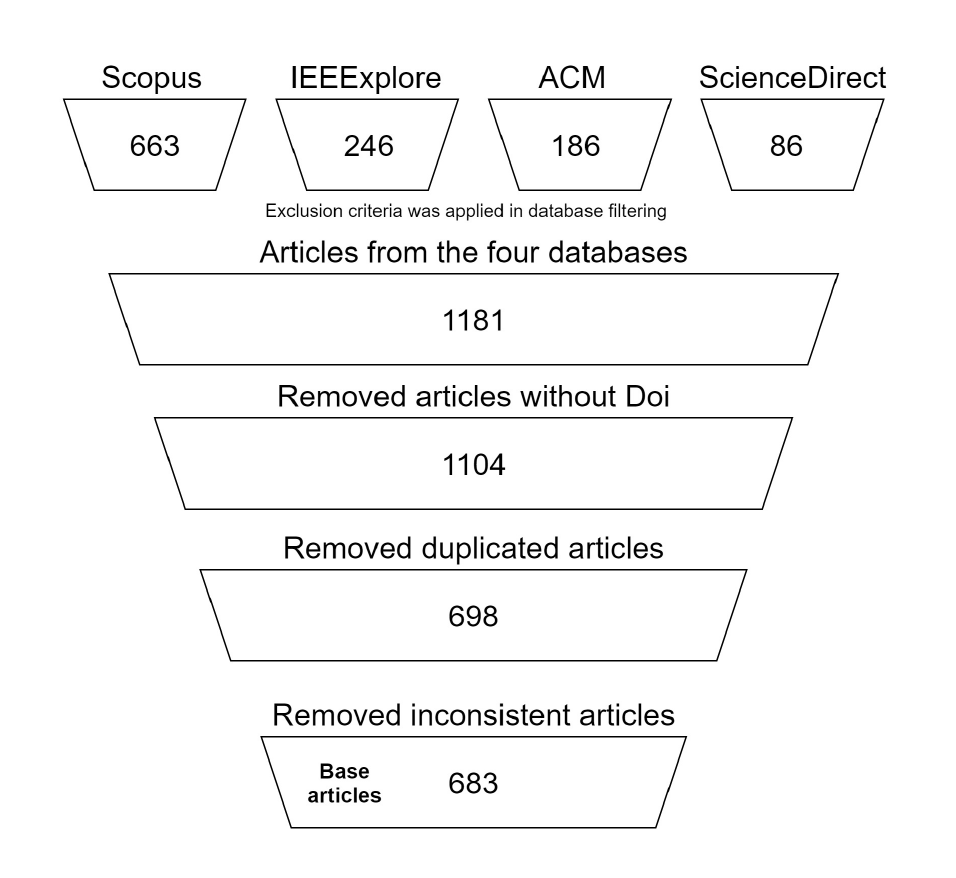
Figure 2. Article